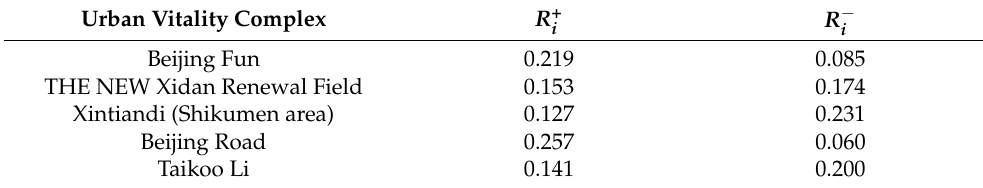
Table 10. Distance from the emotional attachment of each complex to the positive and negative ideal